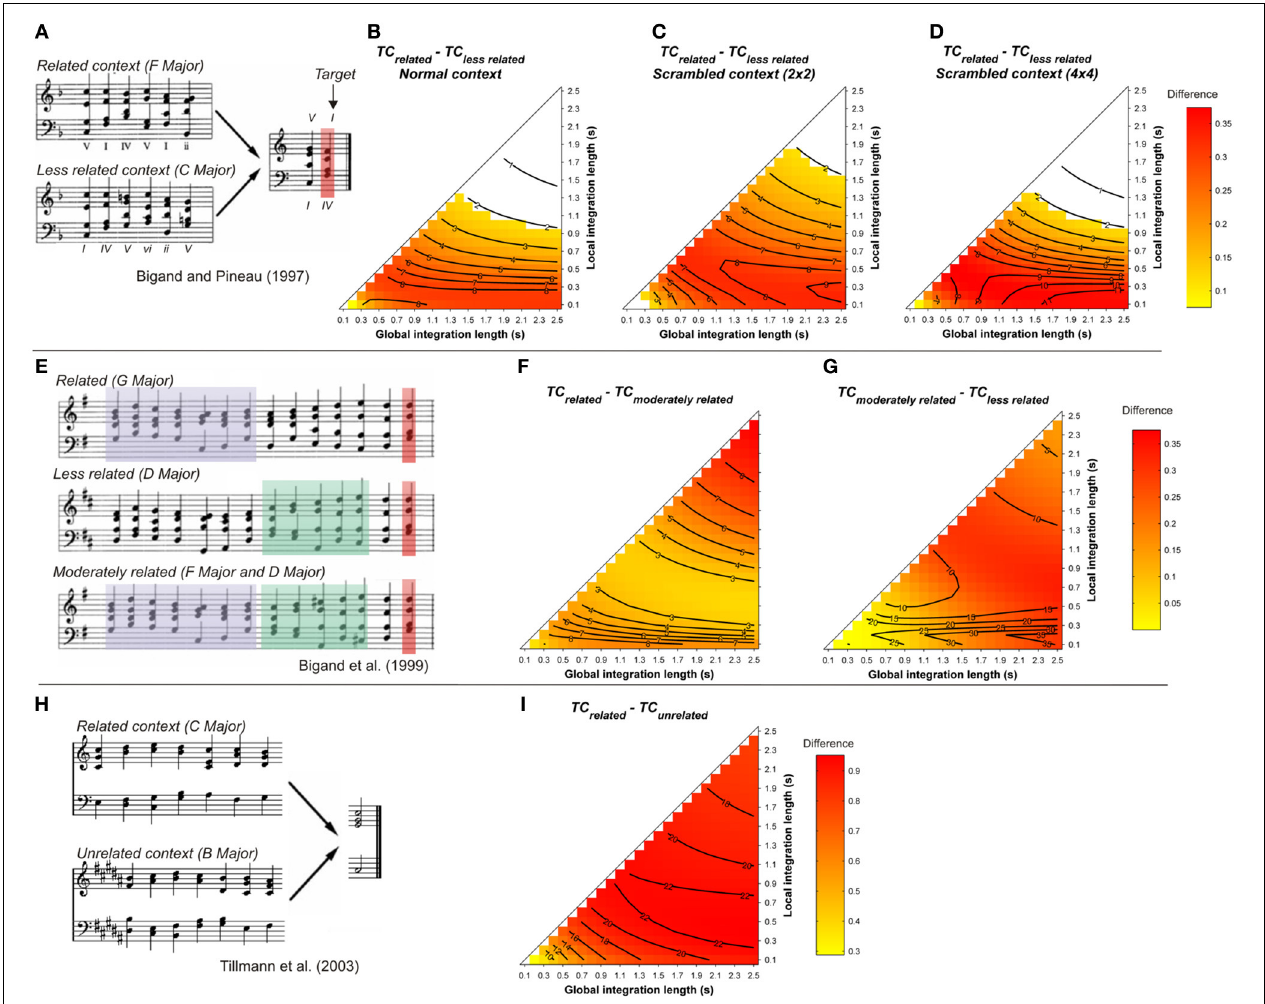
FIGURE 4 | (A) Example sequences from Bigand and Pineau (1997). Mean differences between TC related and TC less related , as a function of the local and global context integration windows, for normal (B) , 2 by 2 (C), and 4 by 4 (D) scrambled contexts (Tillmann and Bigand, 2001). (E) example sequences from Bigand et al. (1999). Mean differences of the TC of the target chord between related vs. moderately related (F) , and moderately